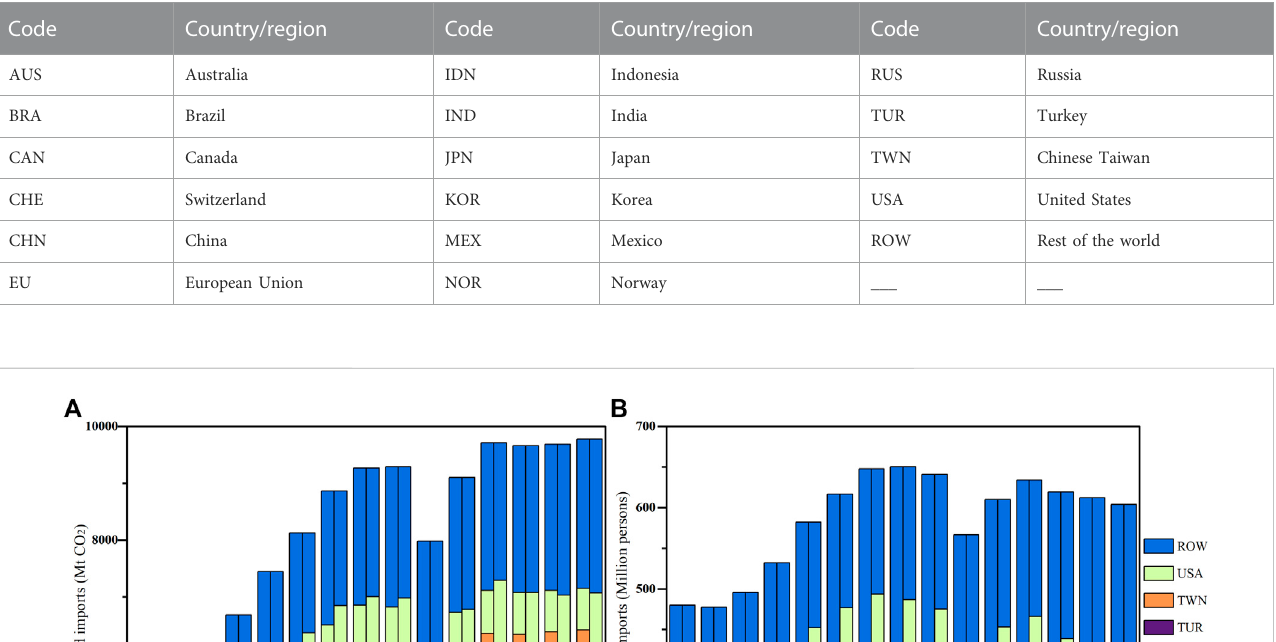
TABLE 2 Country and region classi fi cation.